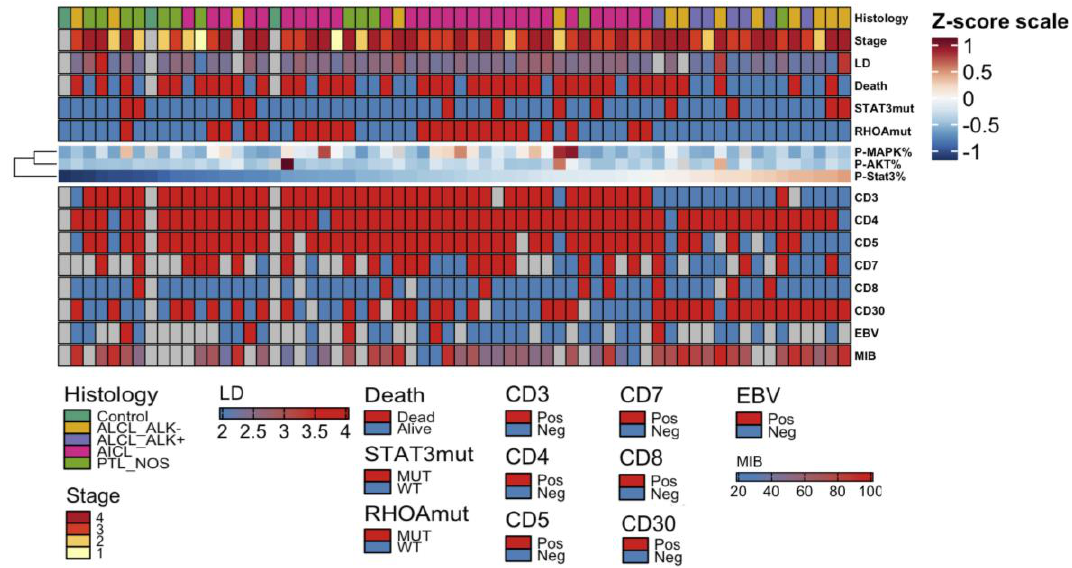
Figure 6. Heatmap visualizing the quantity of pY-STAT3, pMAPK, and pAKT and their association with clinicopathological parameters. The amount of phosphorylated STAT3, MAPK, and AKT have been median-centered and max-scaled, and organized columnwise by pY-STAT3 quantity and rowwise by hierarchical clustering using Spearman correlation distance and Ward linkage (ward.D2) method. Red color denotes higher and blue color lower proportion. Clinical parameters denoting disease histology, disease stage, log10-transformed lactate dehydrogenase (LD) level, survival status, and STAT3 and RHOA mutation status are added as annotations over the heatmap. CD3, CD4, CD5, CD7, CD8, and CD30 immunophenotype status classified as positive or negative, EBV seropositivity and the MIB proliferation index (%) are presented below the heatmap.